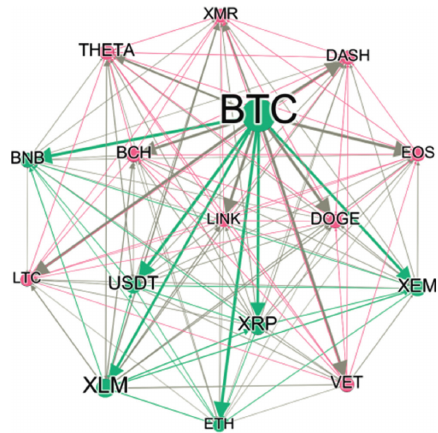
Figure 49: Risk spillover under R8.